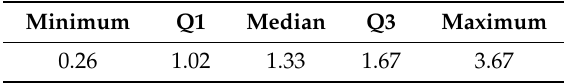
Table 1. Distribution of serum retinol levels ( µ mol/L) in the studied pregnant women. Instituto de